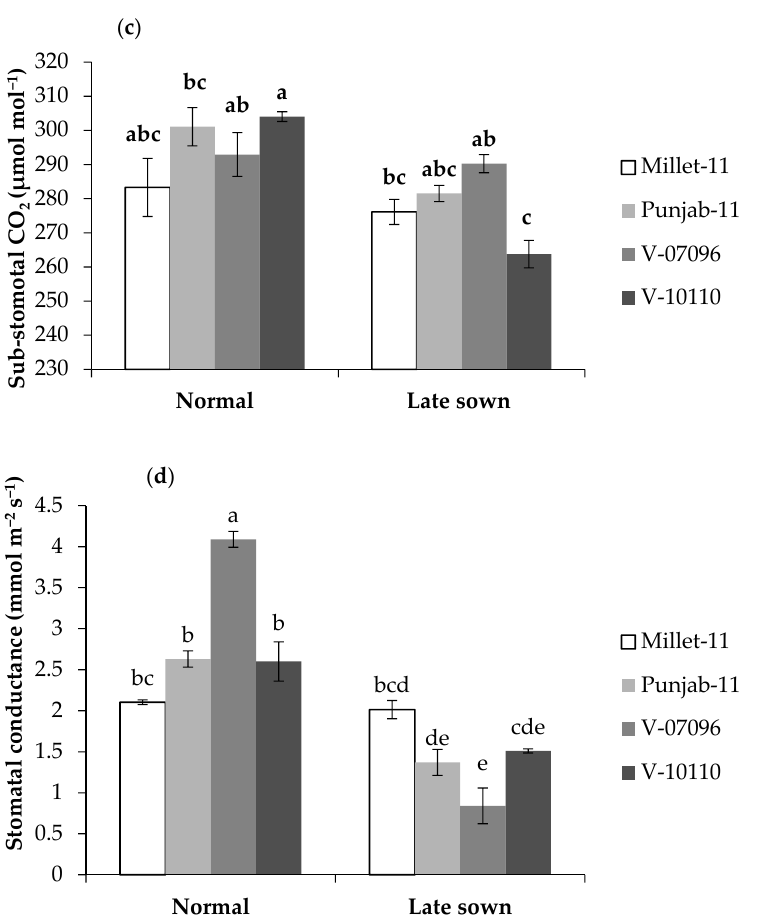
Figure 1. Gas exchange traits ( a ) photosynthetic rate ( b ) transpiration rate ( c ) sub-stomatal CO 2 ( d ) stomatal conductance in wheat genotypes under late sowing. Different lowercase letters indicate significant differences among treatments; Means with same letters show non-significant difference at p > 0.05.